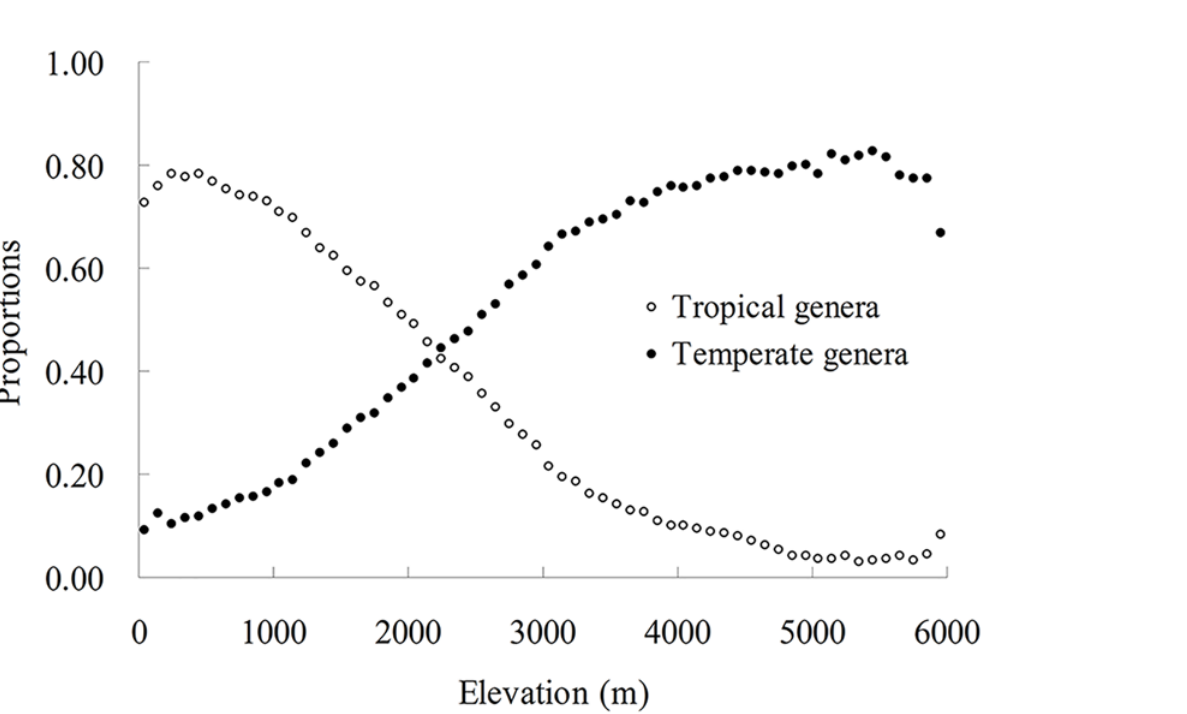
Fig 3. The proportion of tropical and temperate genera along the elevation gradients.